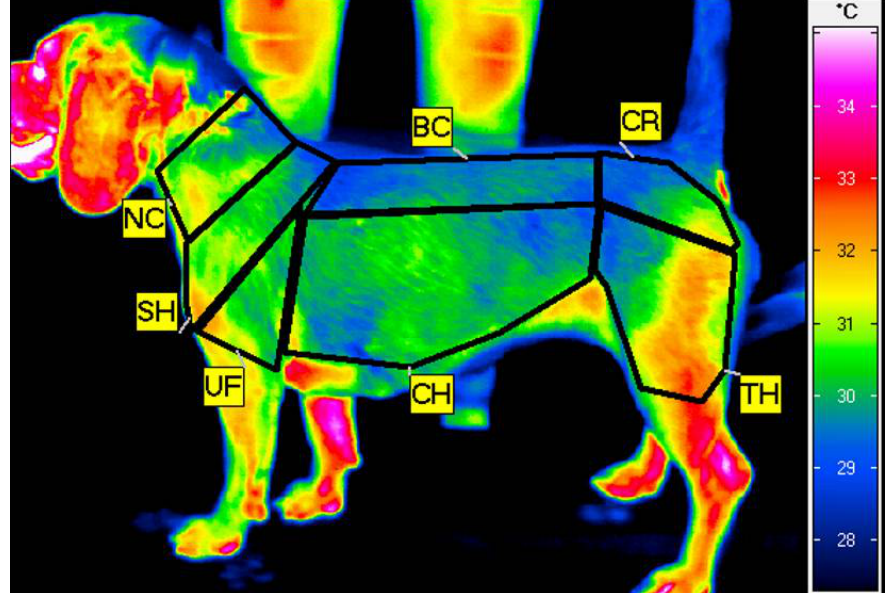
Figure 1. Example thermogram of the left side of the dog taken just after training on the treadmill with the seven regions of interest (ROIs) indicated: neck (NC), shoulder (SH), upper forearm (UF), back (BC), chest (CH), croup (CR), and thigh (TH).